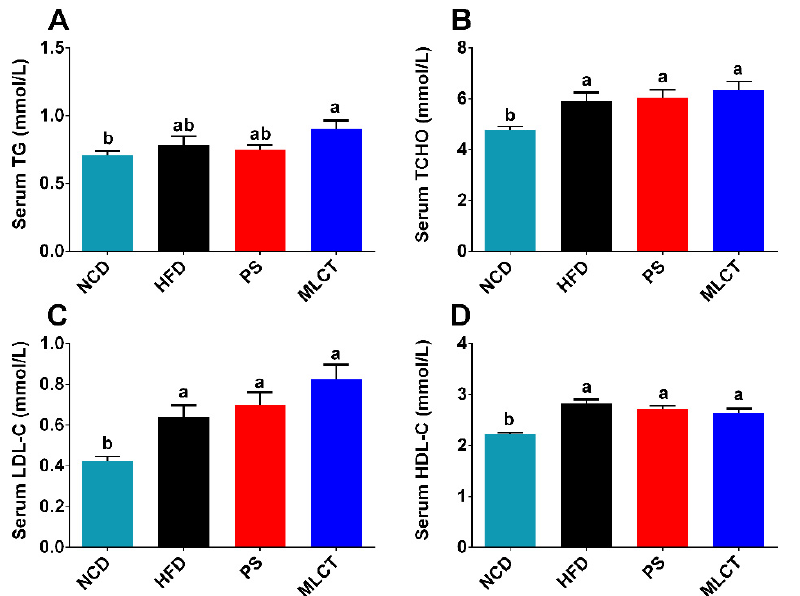
Figure 3. Effects of MLCT on serum lipid profiles. ( A ) TG. ( B ) TCHO. ( C ) LDL-C. ( D ) HDL-C. Data were shown as mean ± SE ( n = 8). In ( A – D ), means with the different lowercased letters differ significantly ( p < 0.05) according to one-way ANOVA analysis followed by Tukey’s tests.